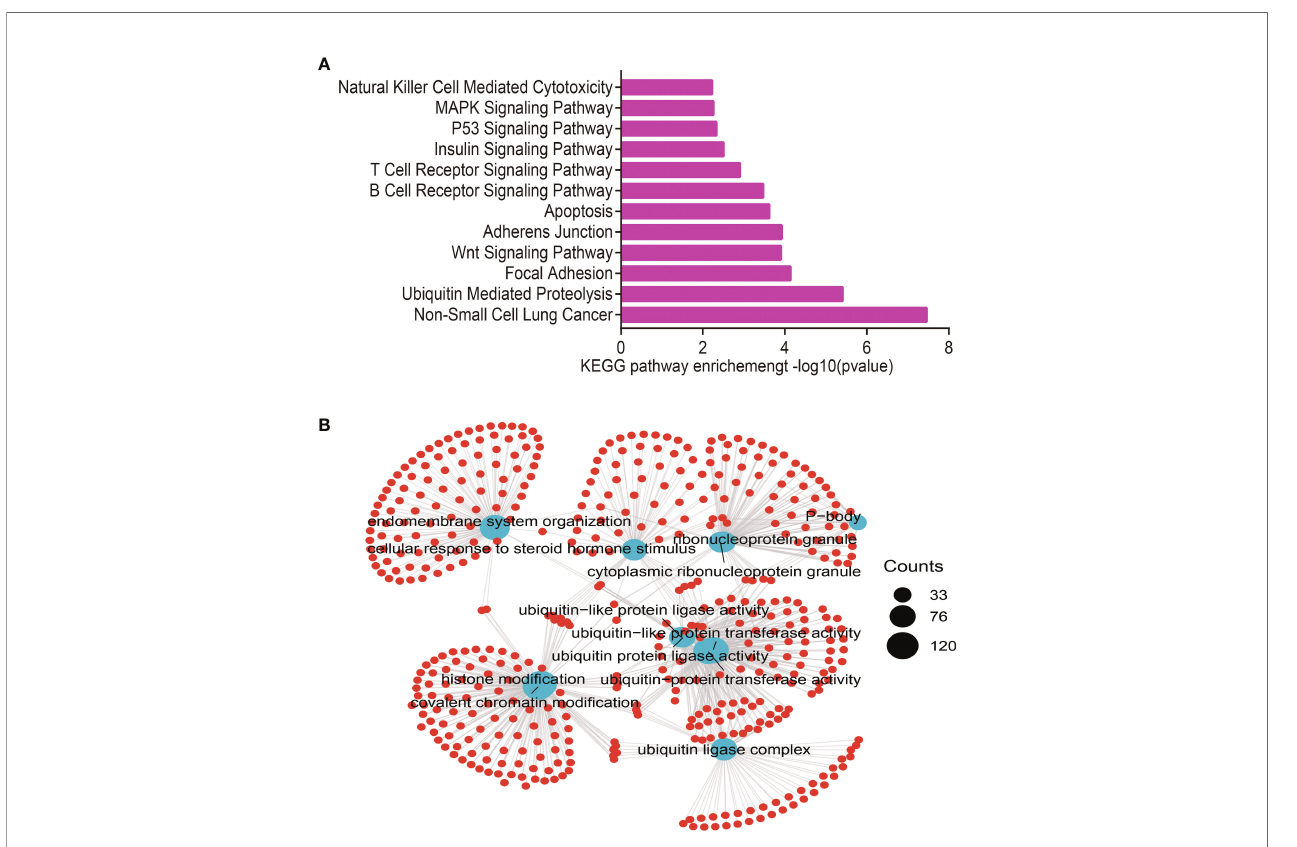
FIGURE 3 | Analysis of the biological function for miRNA-30a-5p downstream target genes in human cancers. (A) The KEGG signaling pathway of miRNA-30a-5p downstream target genes in pan-cancer analysis by the starbase database. (B) The biological process of miRNA-30a-5p downstream target genes in pan-cancer analysis by the